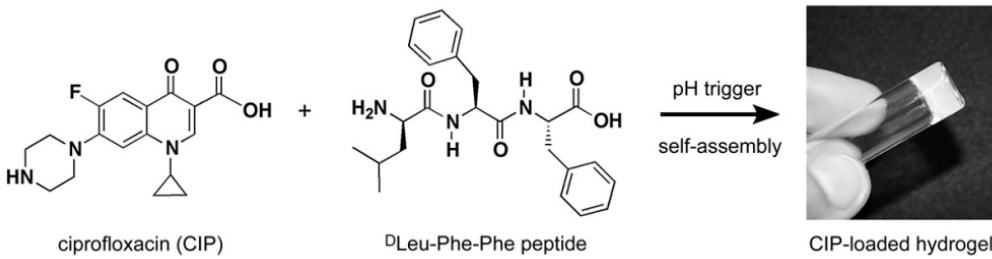
Figure 9. Chemical structures of both ciprofloxacin (CIP) and tripeptide D Leu-Phe-Phe; these structures are able to self-assemble to form a hydrogel following a pH trigger. Reproduced with permission from [25].